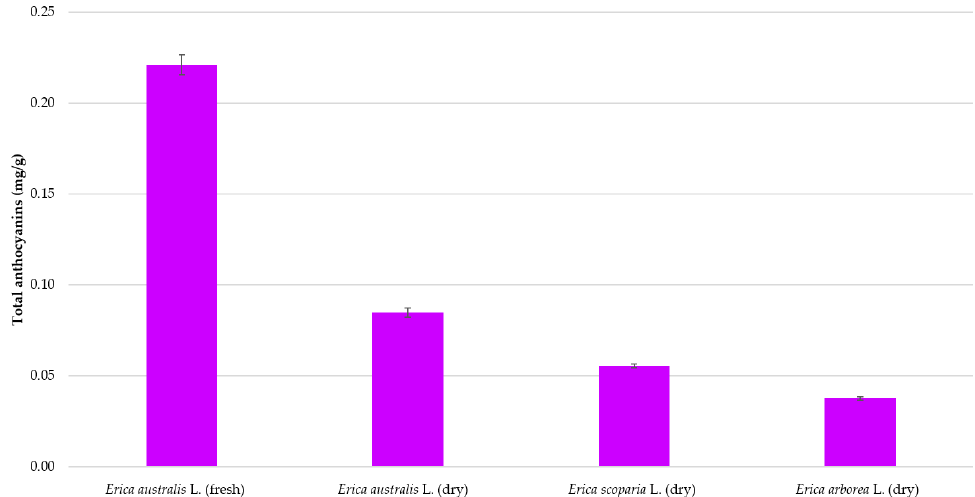
Figure 6. Total anthocyanins recovery from Erica genus flowers extracted under the established optimum conditions ( n = 3).